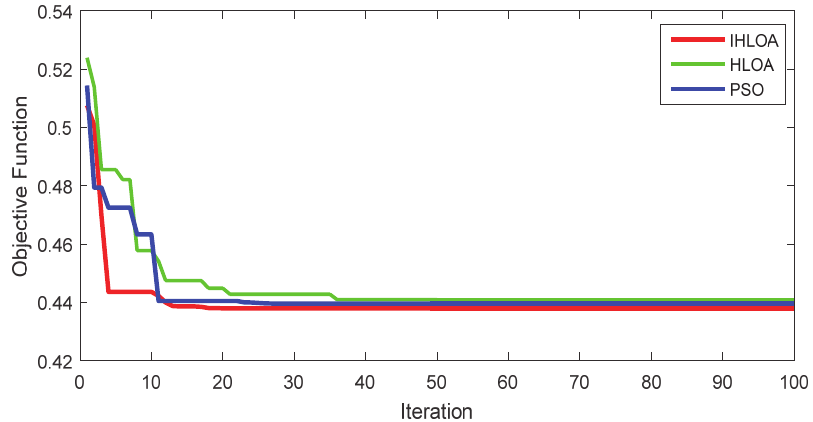
Figure 5. Convergence curve of allocation of two PV in 33 ‐ bus distribution system in the determin ‐ istic case.